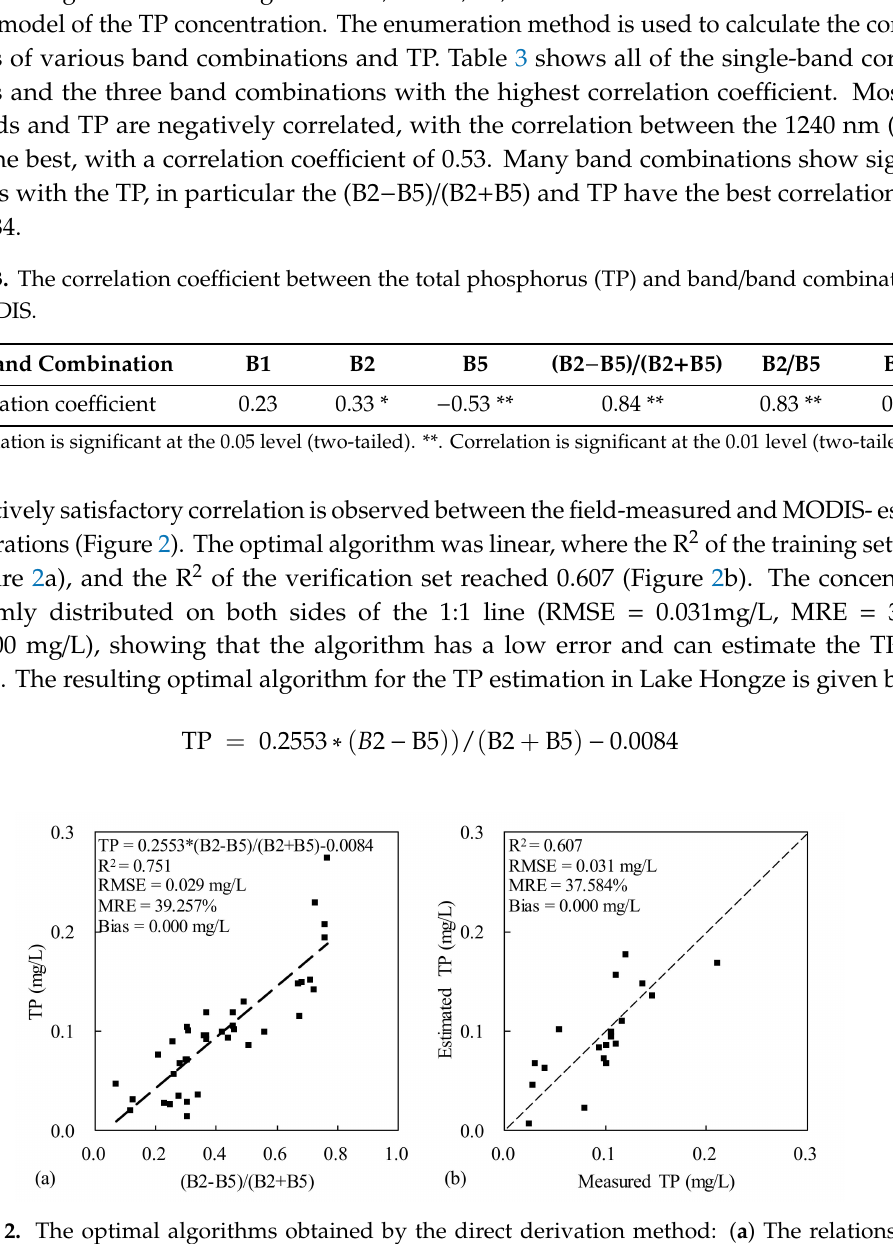
Figure 2. The optimal algorithms obtained by the direct derivation method: ( a ) The relationship between the in situ measured TP and (B2–B5) / (B2 + B5); ( b ) the validation of the MODIS-estimated TP with the in situ measured TP based on an independent